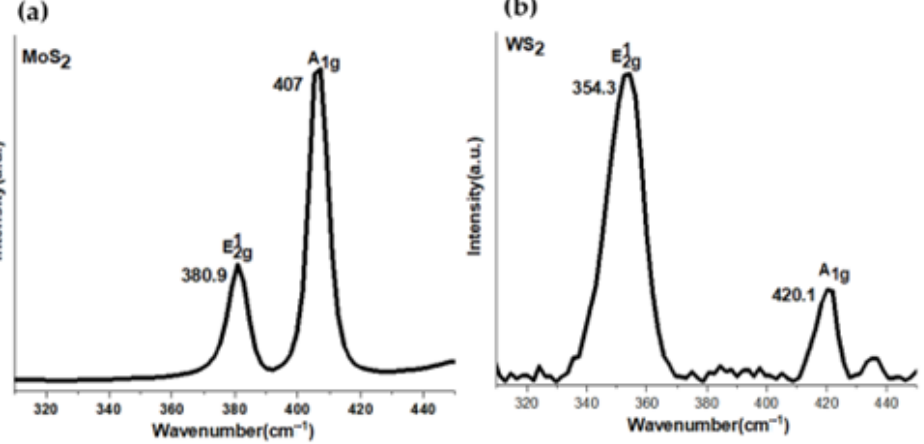
Figure 1. ( a , b ) Raman spectra of MoS 2 and WS 2 on Si substrates, respectively.